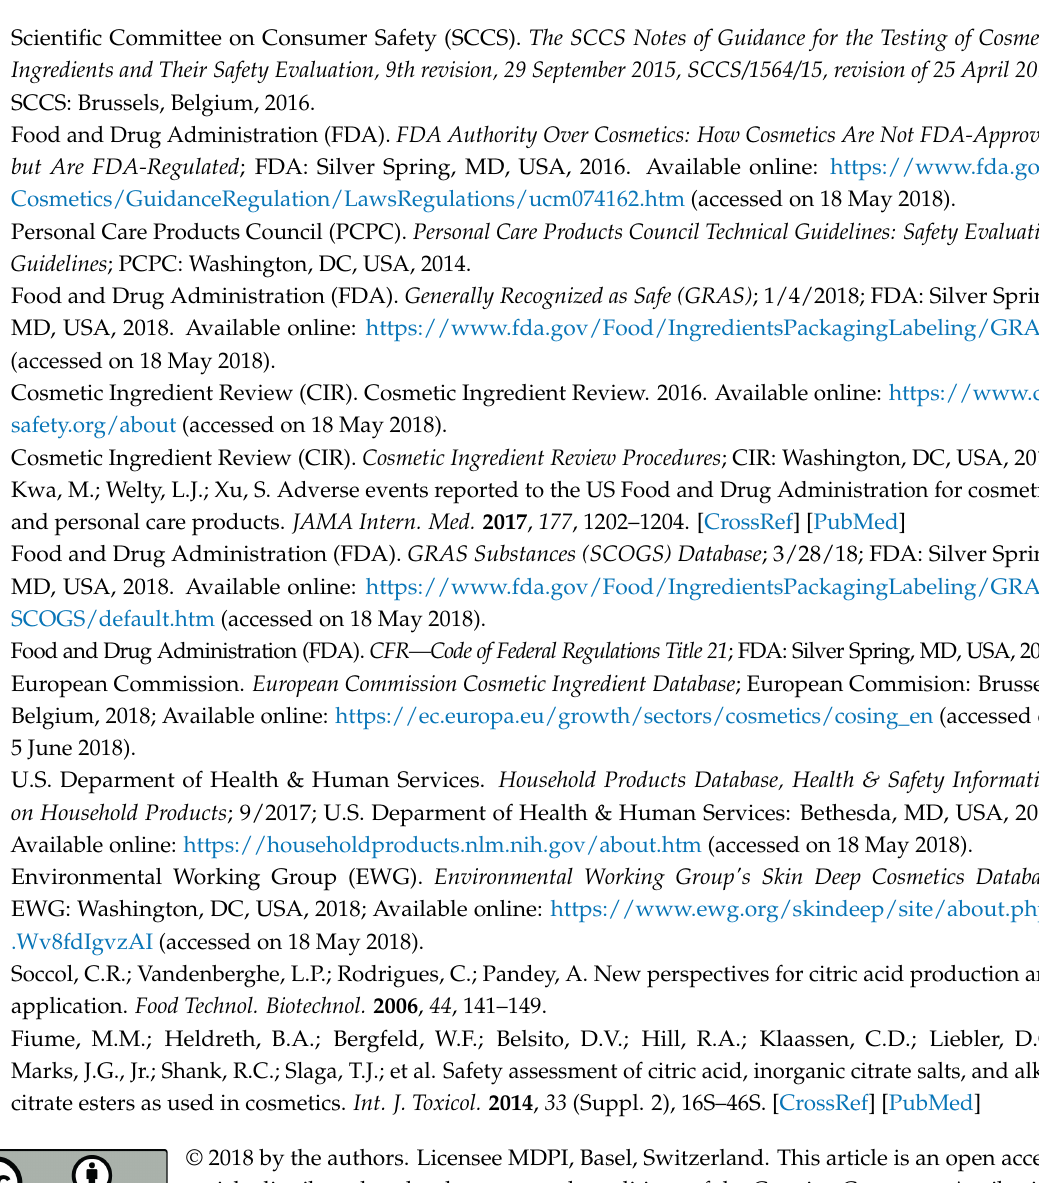
Table S1: Product Listing by Ingredient and Product